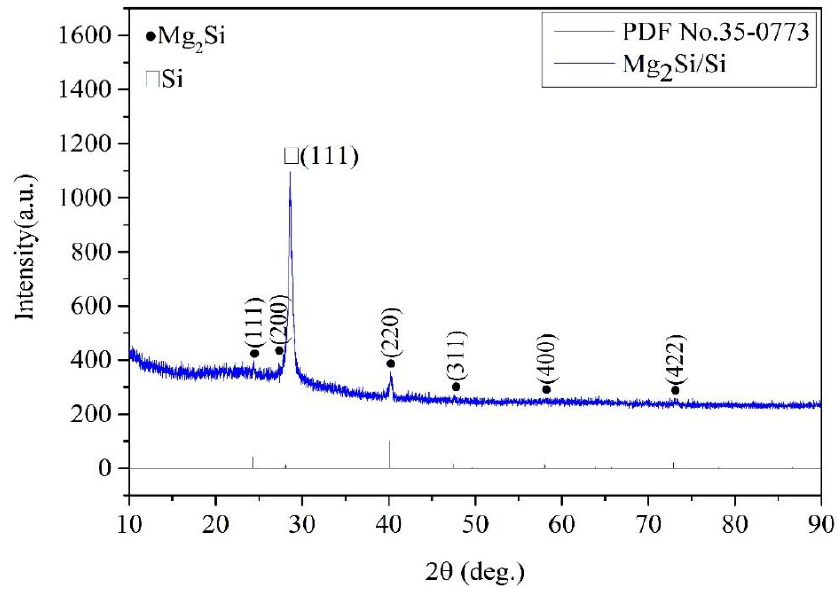
Figure 2. The Mg 2 Si crystal diffraction standard card and XRD spectra of p – Mg 2 Si/n – Si heterojunc- tion.